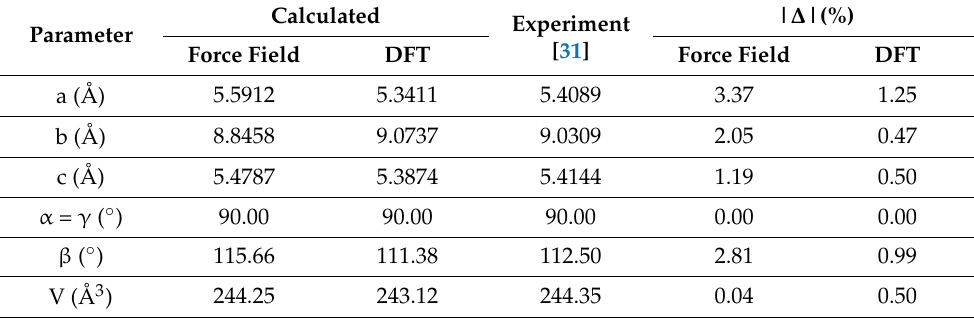
Figure 1. Monoclinic crystal structure of LZO. Table 2. Calculated and experimental lattice parameters of monoclinic